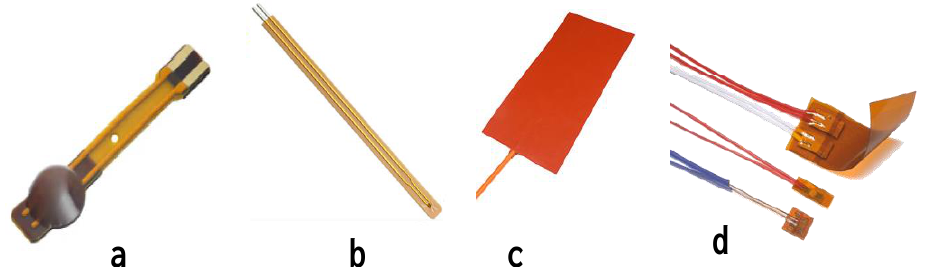
Figure 6. Three different electronic temperature sensors: ( a ) 10 k NTC Thermistor module on Flex Cable; ( b ) 10 k NTC Thermistor Module from Littlefuse [31]; ( c ) Flexible Thermostat heat pad, and ( d ) Thermal-Ribbon™ Flexible RTD [32] were tested for the insole application.